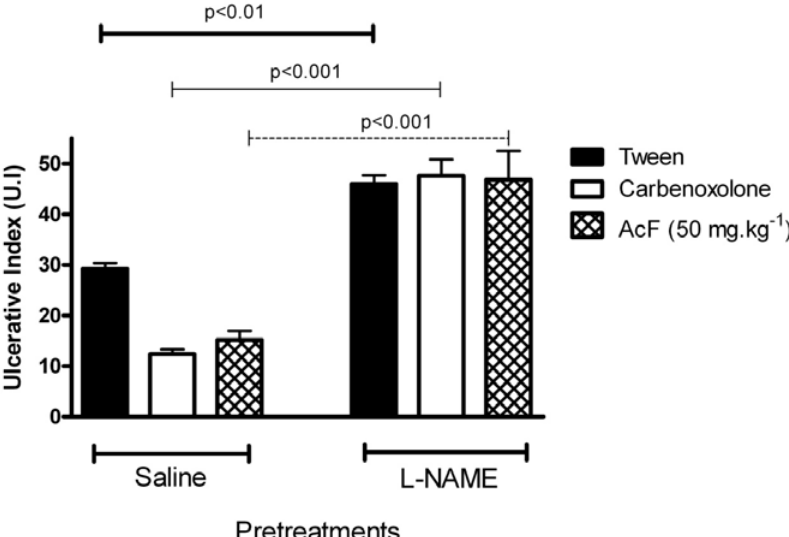
The columns are the mean ± S.D. of five rats. ANOVA: F